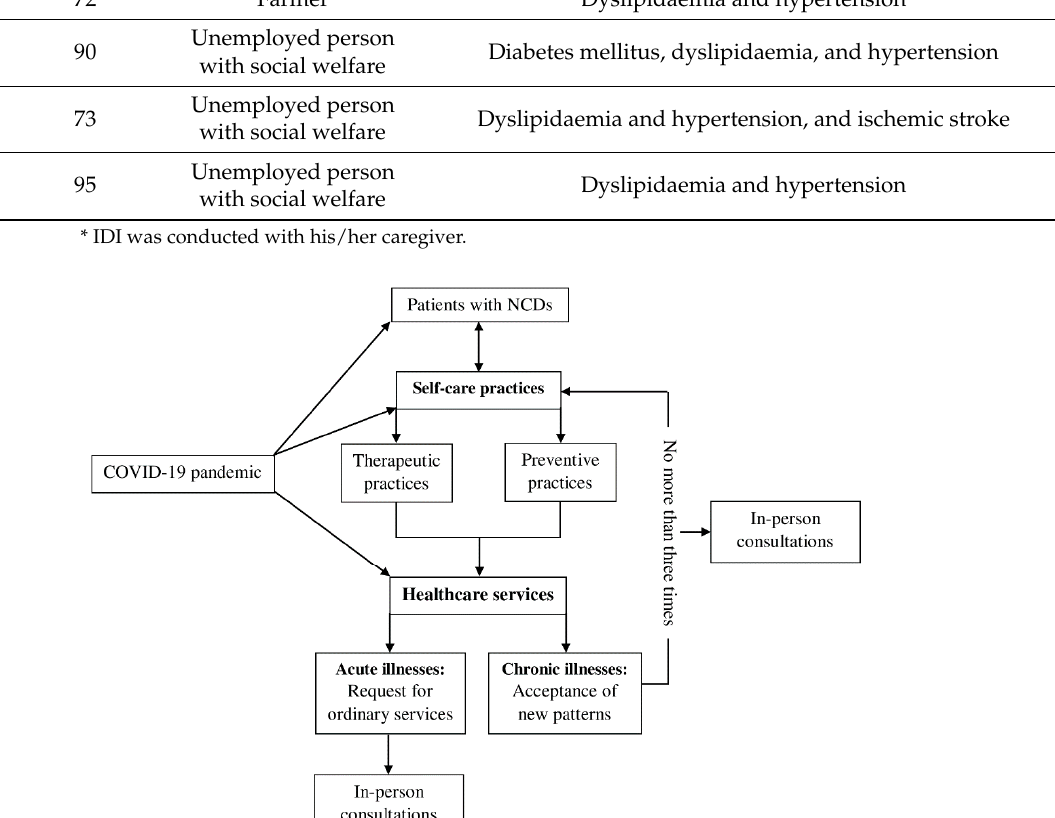
Patients and their families were aware of the COVID-19 pandemic and prioritized